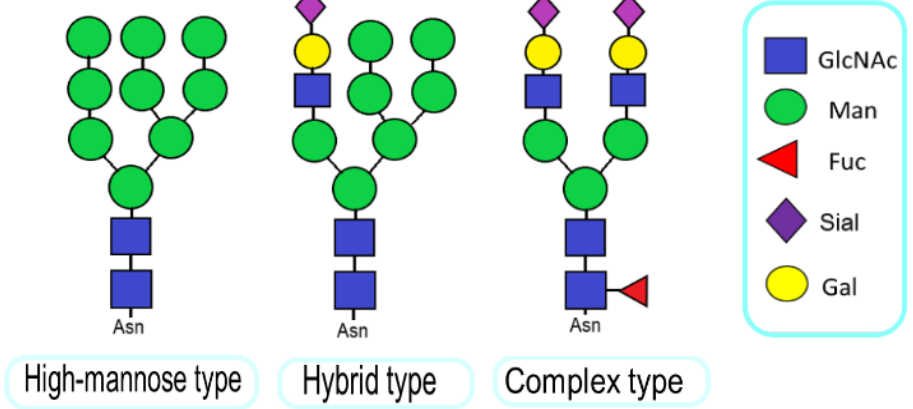
Figure 2. Schematic presentation of N-glycans types.